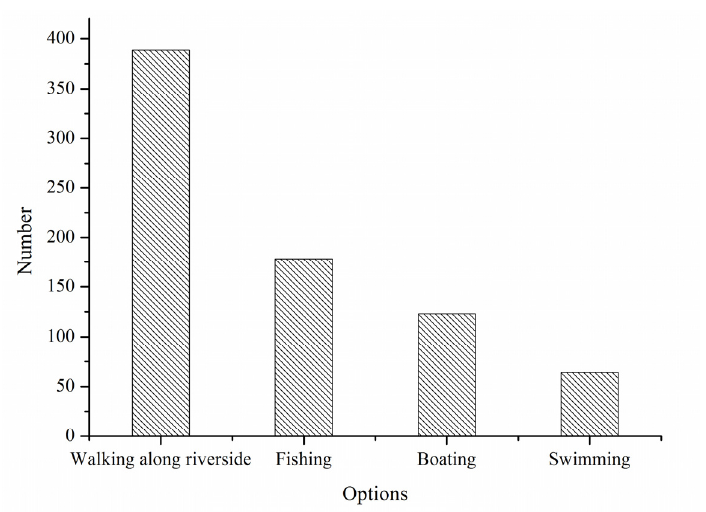
Figure 4. Frequencies of utilization of entertainment functions.